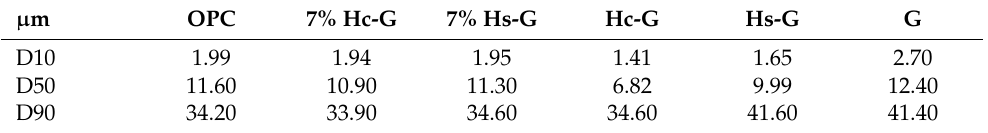
Table 2. Laser-determined D10, D50 and D90 values for the samples